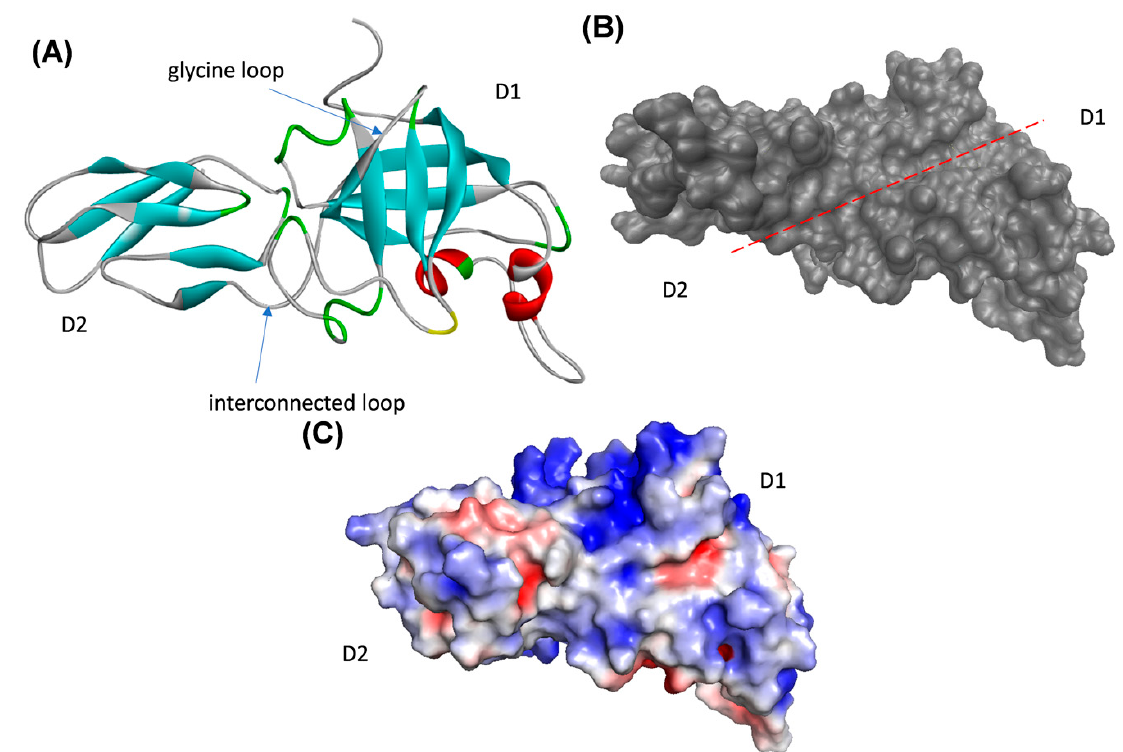
Figure 5. Structural model of DaEXLA2. ( A ) The protein model of DaEXLA2. In red the α -helices that form part of the domain I are shown and in cyan the β -sheets of the two domains are shown. Additionally, each domain was named D1 or D2 (domain I and II), and the interconnected loop is shown between both domains. ( B ) The protein surface and the open groove structure zone is shown using the red line. ( C ) Surface electrostatic potential of DaEXLA2 protein models; the electronegative zone is presented in red, the neutral zone in white, and the electropositive zone in blue.